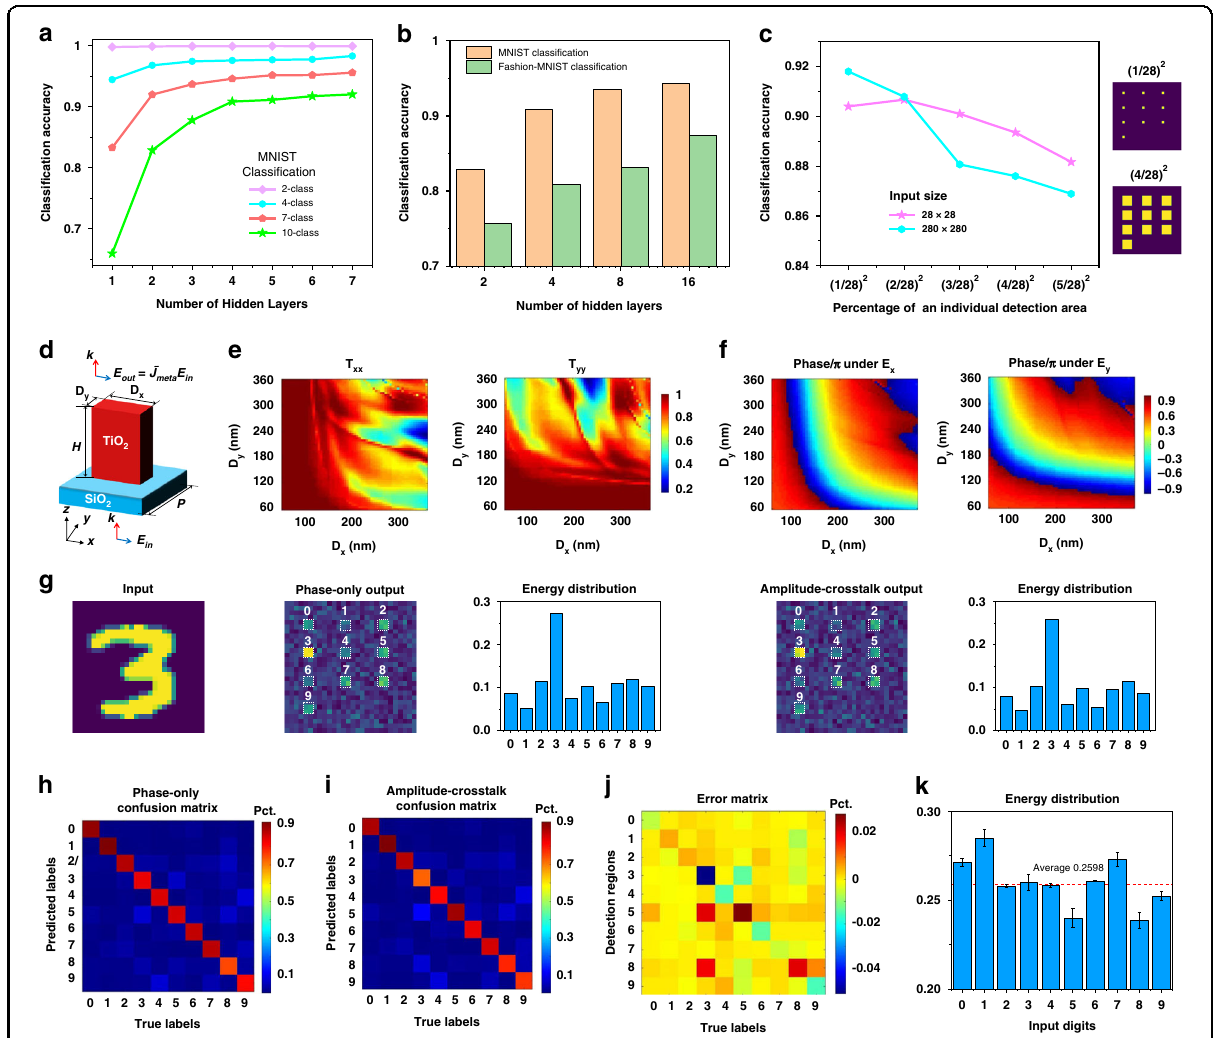
Fig. 2 The training and design of the MDNN. a Variation of MNIST classi fi cation accuracy with respect to the number of hidden layers and classes. b Performance comparisons of MNIST and Fashion-MNIST classi fi ers with 10-class as an example. c Classi fi cation accuracy of MNIST dataset as a function of different percentage of detected regions. d Schematic of a single TiO 2 meta-unit with a fi xed height H , while tunable structure dimensions D x and D y . Each meta-unit acts as a neuron that has multiplexed phase pro fi les trained by machine learning. e , f Simulated values of the transmission coef fi cients ( T xx , T yy ) and the phase shifts ( φ xx , φ yy ) under x - and y -polarized light, respectively. An incident wavelength of 532 nm, a nanopillar period of 400 nm, and a height of 600 nm are assumed. g Simulated output patterns and energy distribution percentages in the detection plane corresponding to a handwritten input of “ 3 ” , in the case of phase-only and amplitude-crosstalk networks, respectively. The confusion matrixes for h phase-only (amplitude is considered to be a constant value) and i amplitude-crosstalk MDNN are demonstrated, where the amplitude-crosstalk is based on the complex amplitude of the meta-unit in c . Pct. percentage. j Percentage error matrix between h and i . k Percentage of energy distribution for each digit of the network with amplitude-crosstalk. The error bars show the differences in comparison with the phase-only